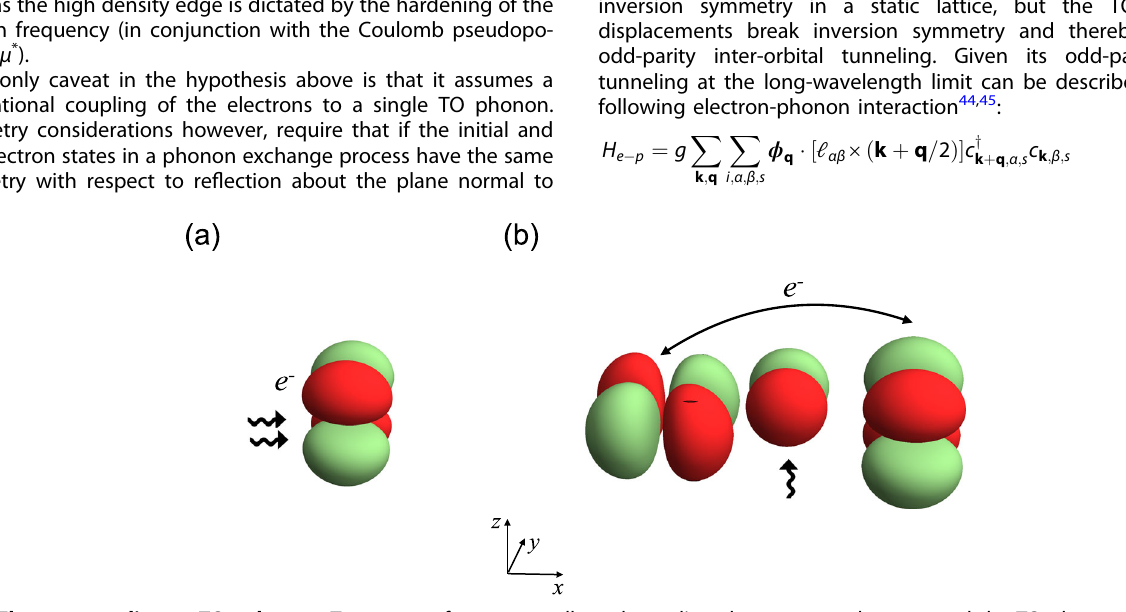
Fig. 1 Electron coupling to TO1 phonon. Two types of symmetry allowed couplings between t 2 g electrons and the TO phonons. In a two phonon process ( a ), a pair of TO phonons, each denoted by a wavy line oriented along the displacement axis, couples to the electron density. b Single-phonon processes can occur provided the tunneling occur between two distinct t 2 g orbitals on the nearest neighbors. Along the crystalline x axis, a TO displacement along the z-direction couples the d xy and d yz orbitals. The wavy line denotes the TO phonon displacement